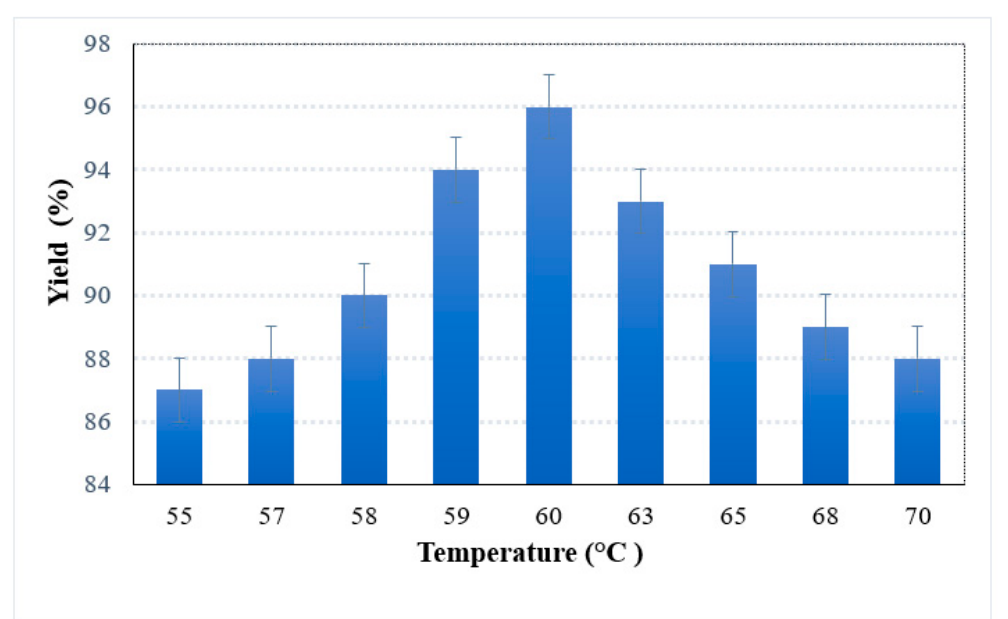
Figure 8. Effect of reaction temperature on biodiesel production.